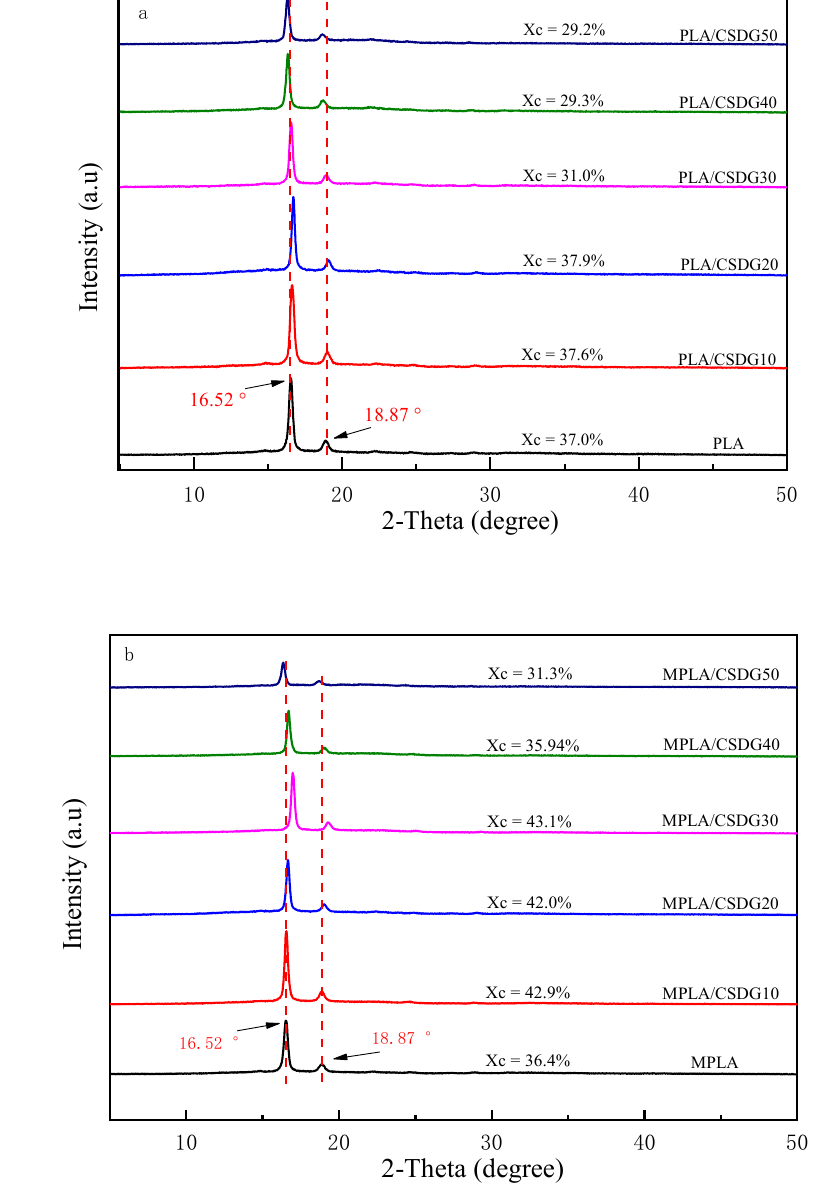
Figure 3. X-ray diffraction patterns: ( a ) PLA/CSDG; ( b )